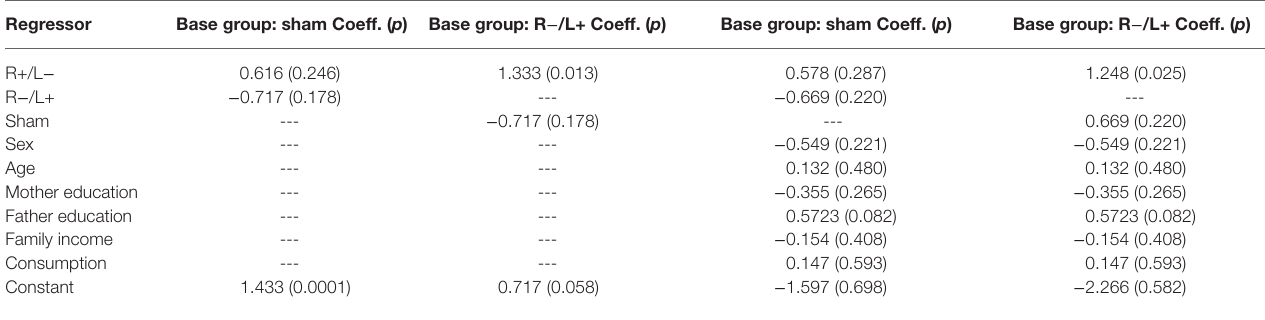
TABLE 2 | Antisocial behavior with cost. Regressor